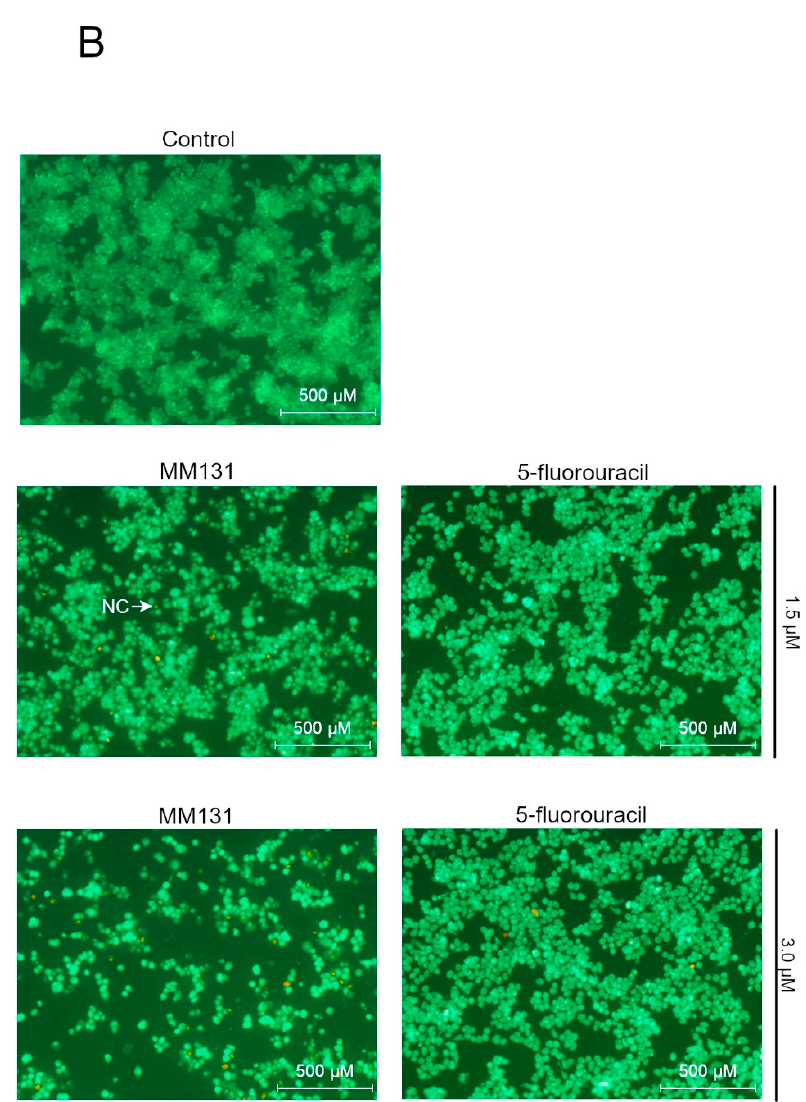
Figure 4. Visualization of morphological specificity of colorectal cancer cells DLD-1 ( A ) and HT-29 ( B ) exposed to MM131 and 5-fluorouracil for 24 h of incubation stained with acridine orange and ethidium bromide. Arrows and abbreviations indicate formation of: VC—viable cells, EC—early apoptotic cells, LC—late apoptotic cells, NC—necrotic cells. Magnification 100×.